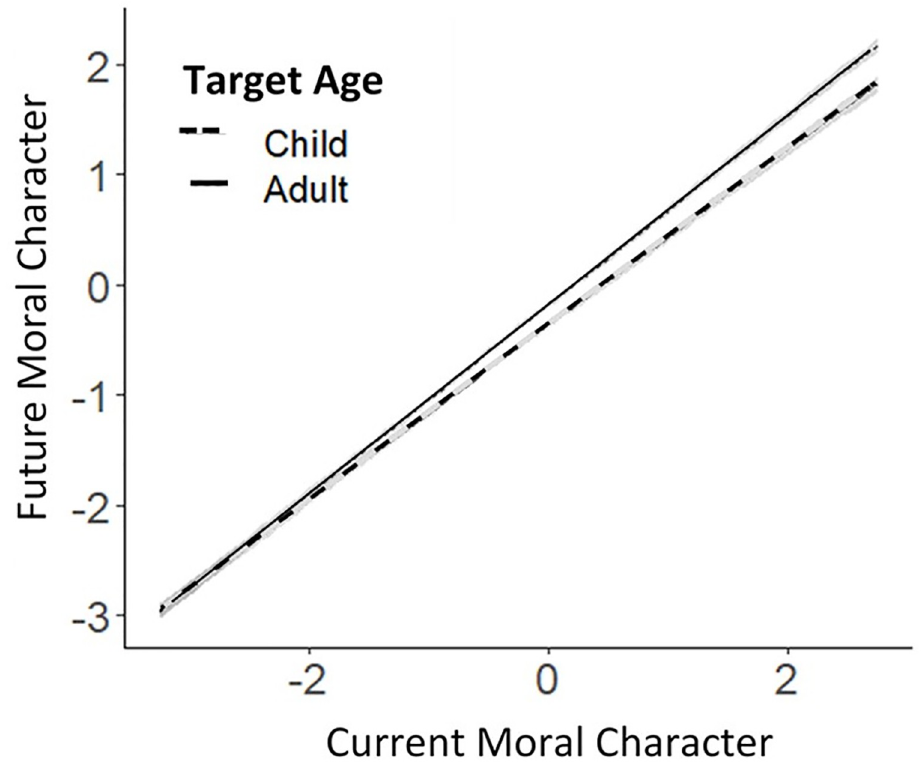
Fig 1. Regression, with 95% confidence bands, showing that the target’s age (adult or child) moderated the relationship between inferences about current moral character and forecasts about future moral character. Regression lines are plotted from data aggregated across all studies.